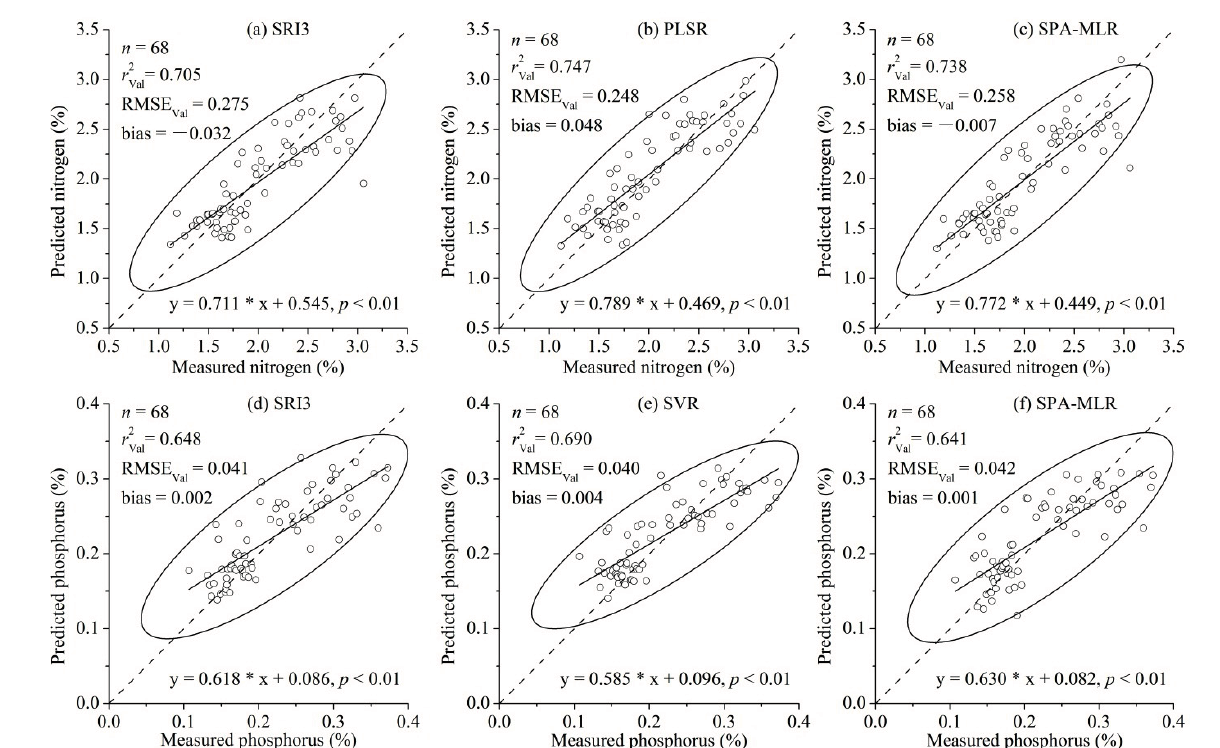
Figure 1. ( a – f ) Scatter plots of measured and predicted values based on the best-performing VI (first column), best-performing multivariate regression (second column) and SPA-MLR (third column ) model for N and P estimations, respectively. The dotted and solid lines present the 1:1 line and linear fitting line between measured and predicted values, respectively. The ellipse denotes the 95% confidence